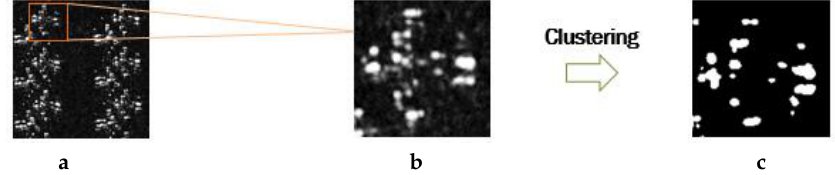
Figure 1. Sparsity in high-resolution SAR imagery. ( a ) Many aircraft targets; ( b ) One airplane extracted from Figure 1a; ( c ) The airplane is presented as scattering points after